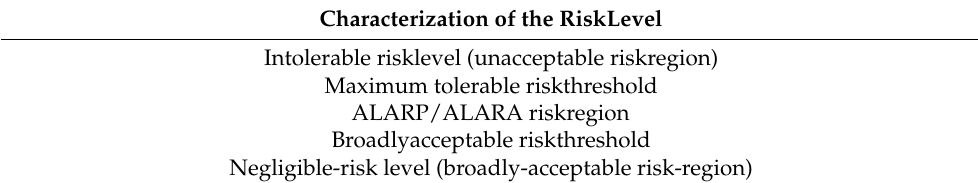
Table 1. Characterization of the risk levels (and risk regions) used by the literature for the I-R RACs developed internationally.